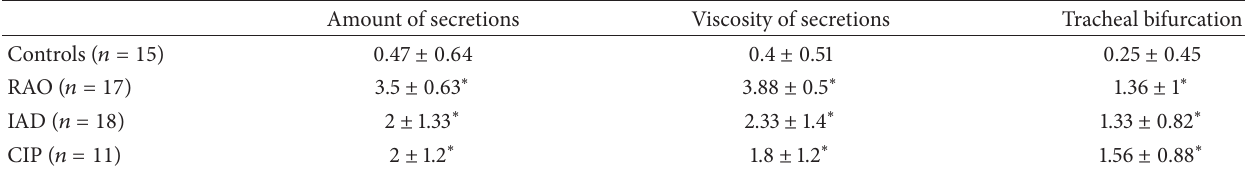
Table 3: Results of endoscopic examination. ∗ shows significant increase to controls at 𝑝 < 0.05 . RAO: recurrent airway obstruction, IAD: inflammatory airway disease, and CIP: chronic interstitial